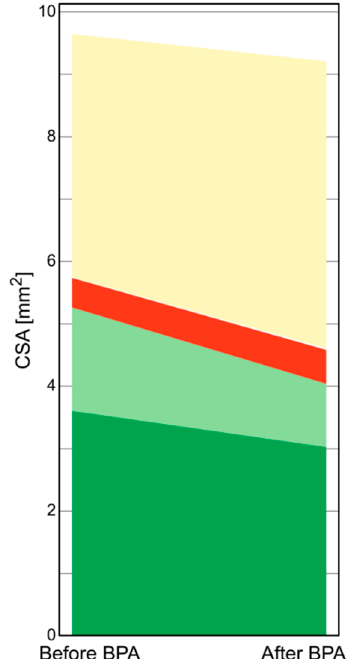
Figure 4. Changes in the organized thrombus composition in the type B ( n = 49) response to BPA. There was an overall decrease in the T-CSA by 0.9 ( − 2.0; − 0.1) mm 2 ; p = 0.001. The L-CSA increased by 0.8 (0.6–1.7) mm 2 ; p = 0.001 along with the decrease in the amount of light-green component (0.4 ( − 1; 0] mm 2 ; p = 0.005). There was no significant change in the dark-green ( ∆ = − 0.15 ( − 0.8; 0.3) mm 2 ; p = 0.07), red ( ∆ = 0 ( − 0.2; 0.3) mm 2 ; p = 0.65) and white ( ∆ = 0 (0; 0.1) mm 2 ; p = 0.56) components of the organized thromboembolic lesions. Abbreviations: BPA—balloon pulmonary angioplasty; CSA— cross-sectional area; L-CSA—lumen cross-sectional area; T-CSA—organized thrombus cross-sectional